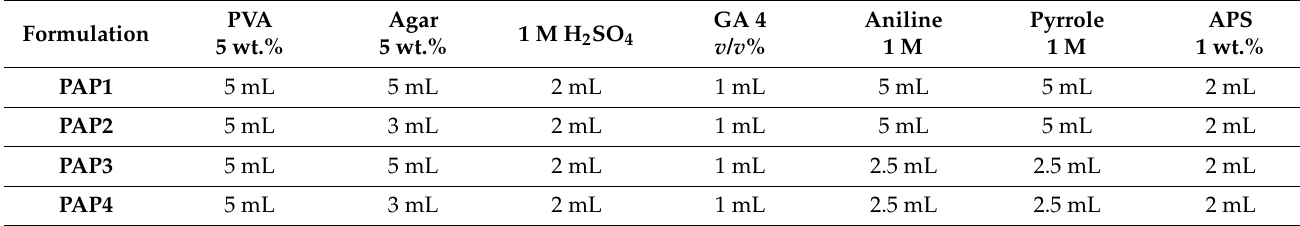
Table 1. Composition of all samples.